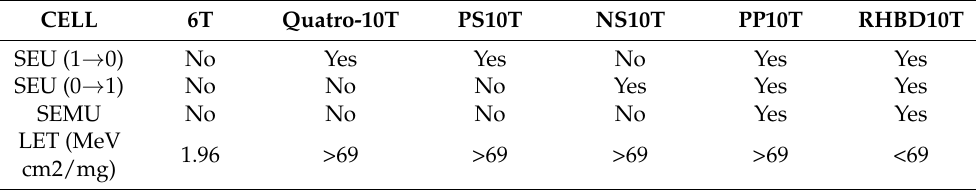
Table 1. 10T hardened cell